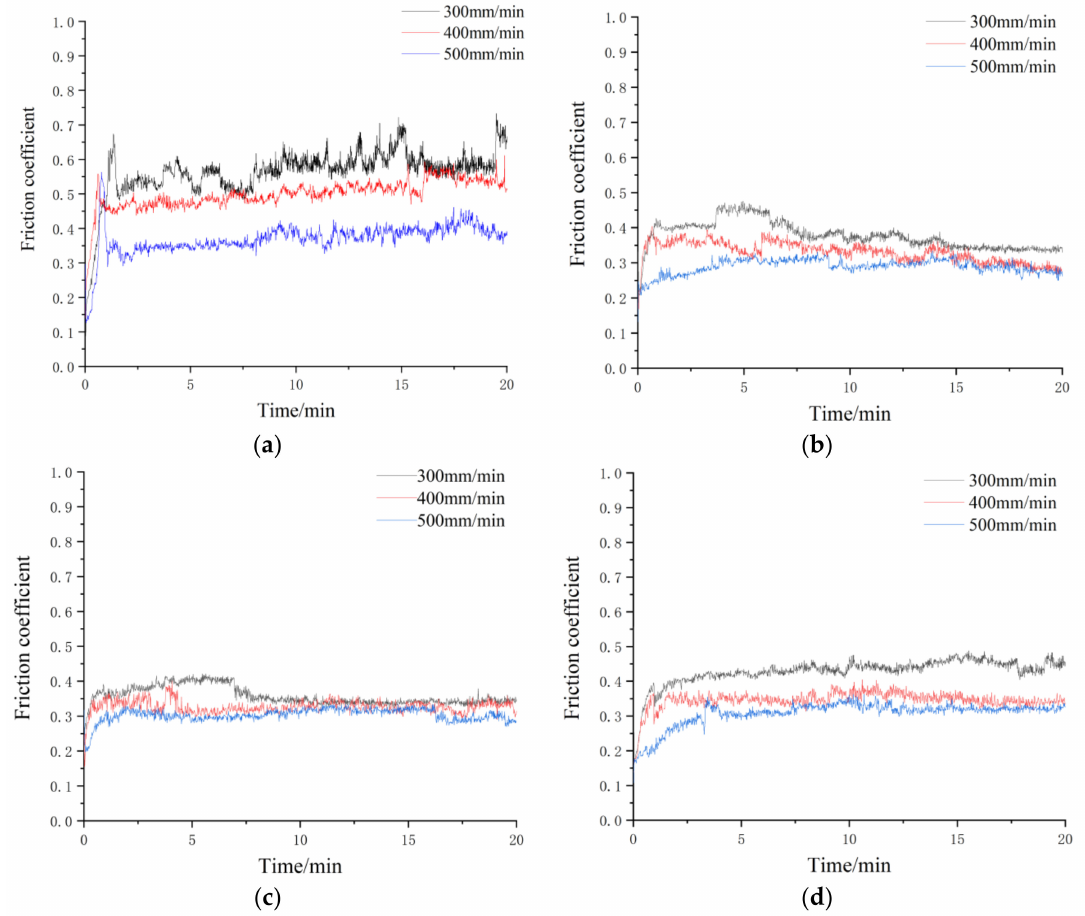
Figure 17. Variation of friction coefficient; ( a ) friction coefficient of the matrix, ( b ) friction coefficient after laser hardening with a scanning speed of 700 mm/min, ( c ) friction coefficient after laser hardening with a scanning speed of 800 mm/min, and ( d ) friction coefficient after laser hardening with a scanning speed of 900 mm/min.